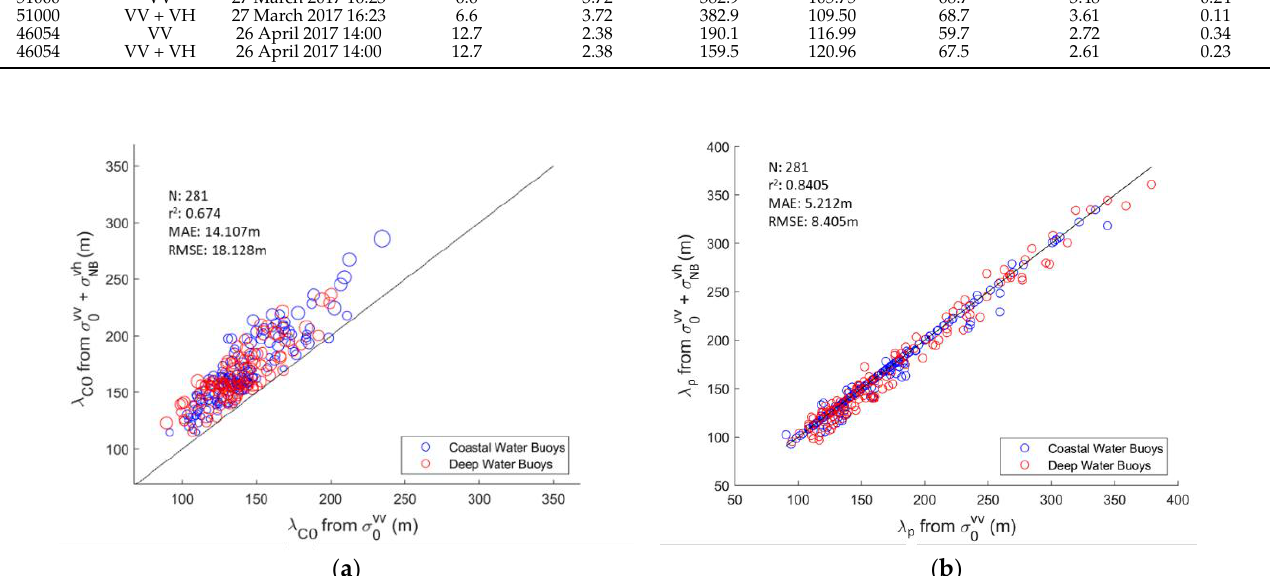
Figure 4. Estimated azimuth cut-off wavelengths ( a ) and dominant wavelengths ( b ) from both VV and VH polarization NRCS data versus those from VV polarization NRCS data alone.